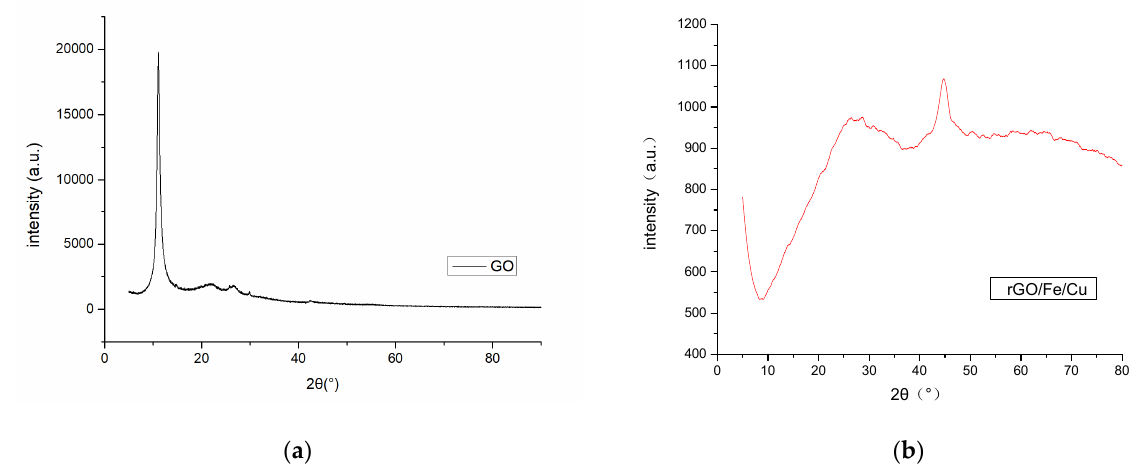
Figure 4. X-ray diffraction (XRD) patterns of ( a ) GO and ( b ) rGO/Fe/Cu nanocompounds.